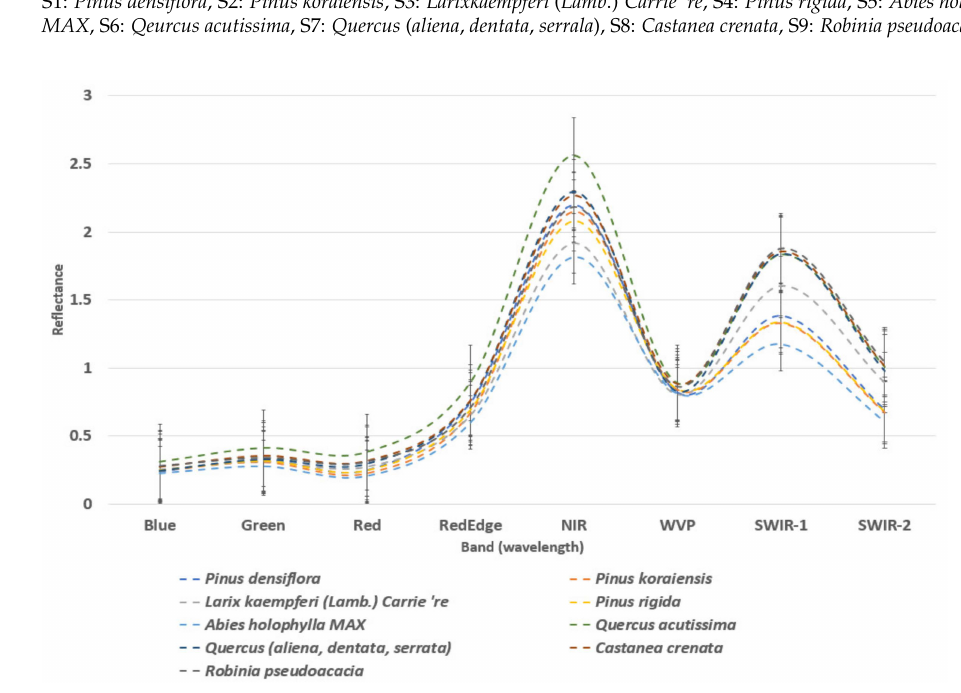
Figure 6. Spectral Distribution according to the Tree